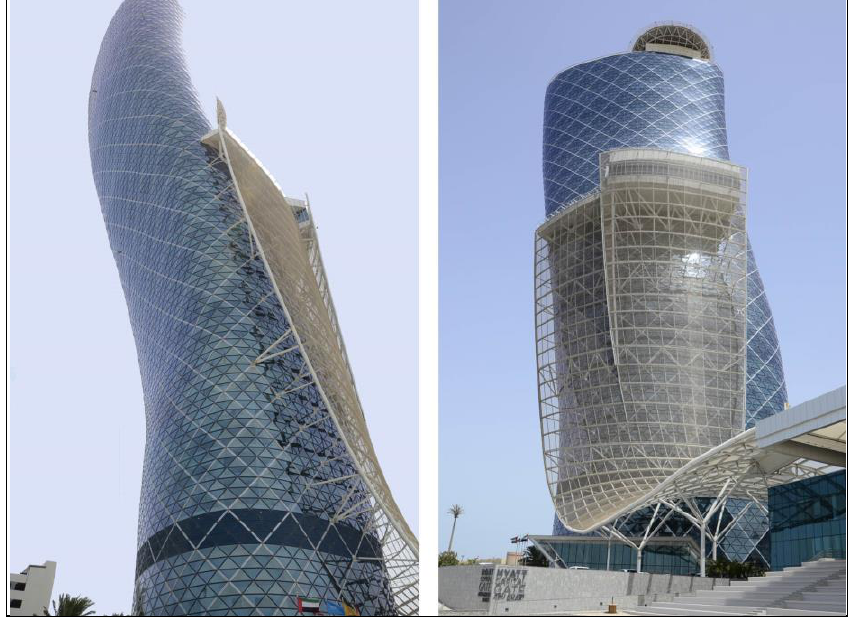
Figure 18. Capital Gate Tower (photograph by authors).